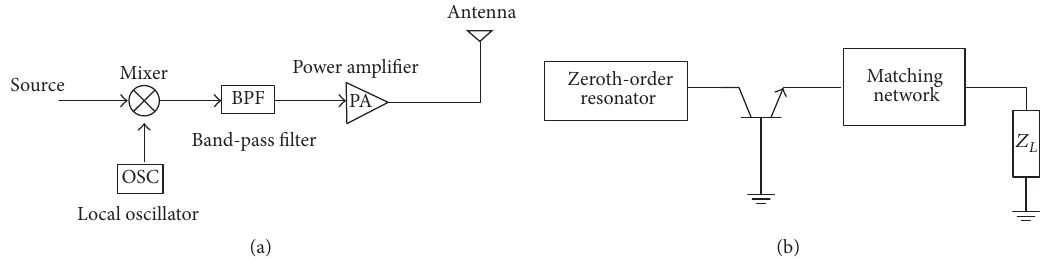
Figure 1: (a) The block diagram of telecommunication system. (b) The block diagram of oscillator.